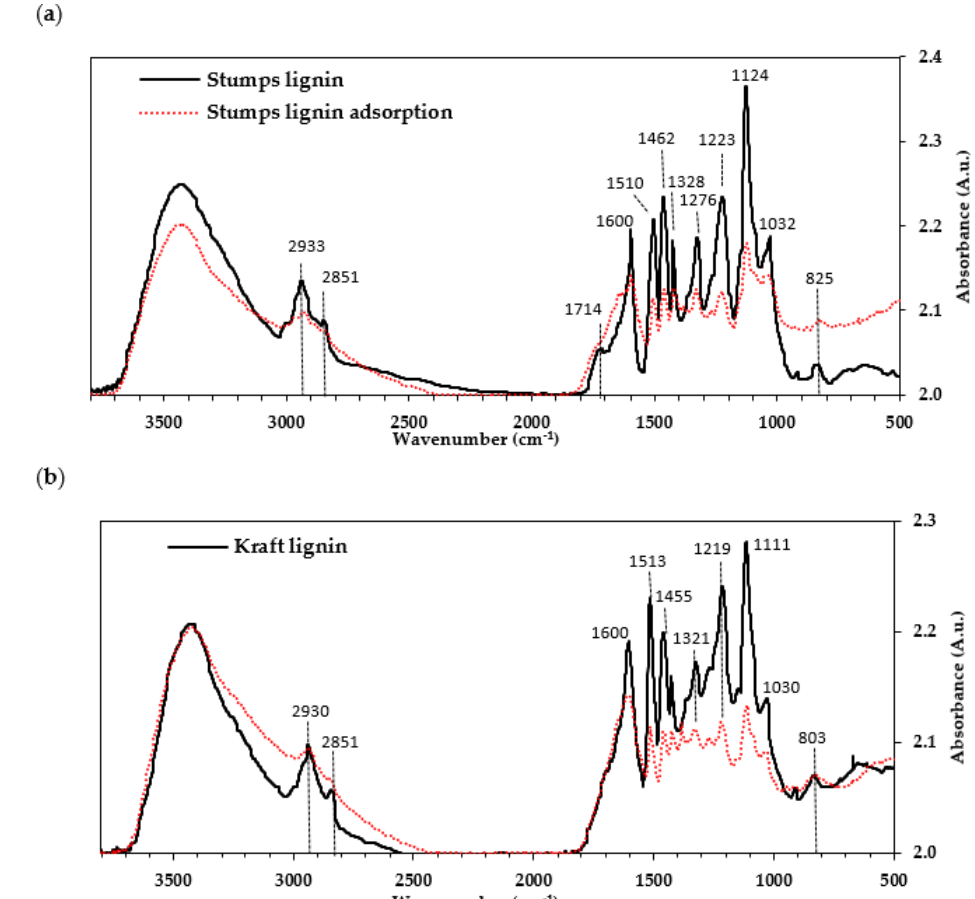
Figure 9. FTIR spectra of lignin samples before and after adsorption of Cr(VI) depicted in the region 500–3800 cm − 1 : eucalypt stump lignin ( a ) and kraft lignin ( b ). Measurements in absorbance units (A.u.).